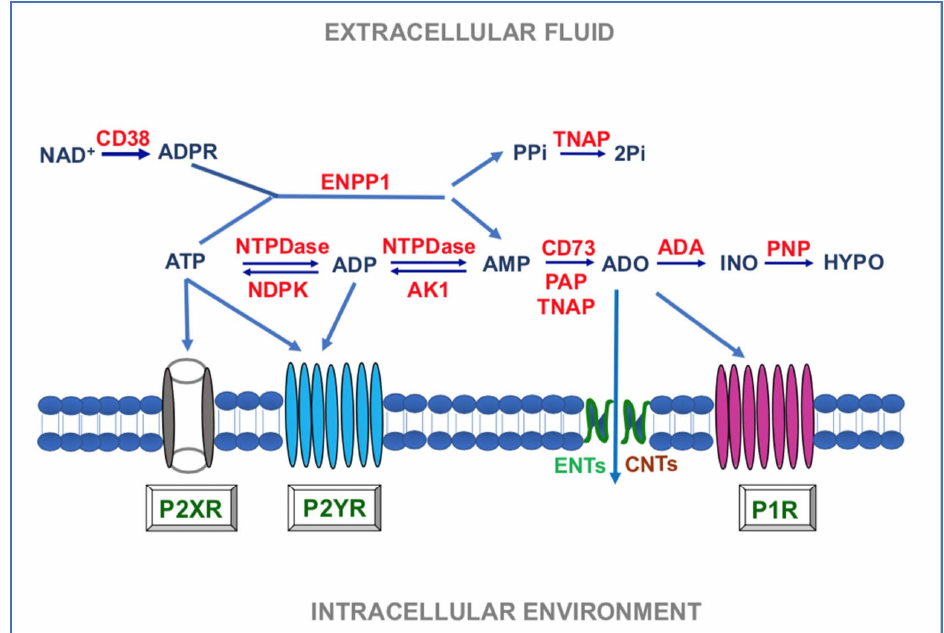
Figure 1. Main enzymes involved in the metabolism of extracellular purine. ADO: adenosine;